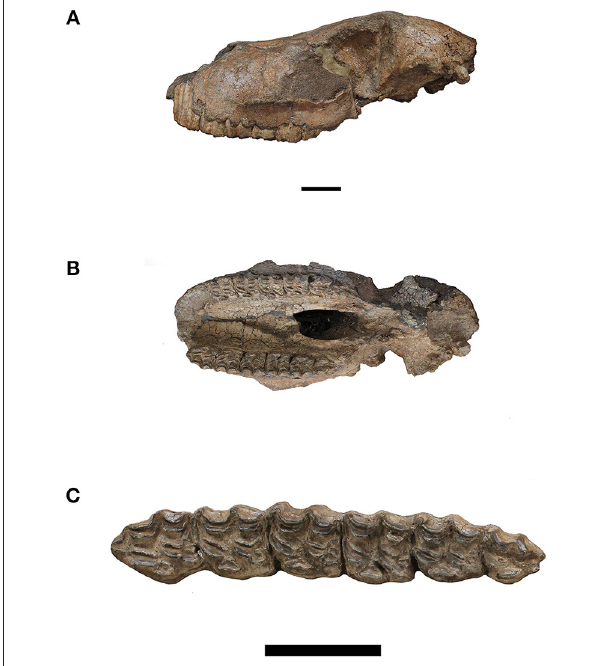
FIGURE 10 | Equus cf. tabeti . (A) Skull in lateral view; (B) Skull in ventral view; (C) Upper tooth row in occlusal view.